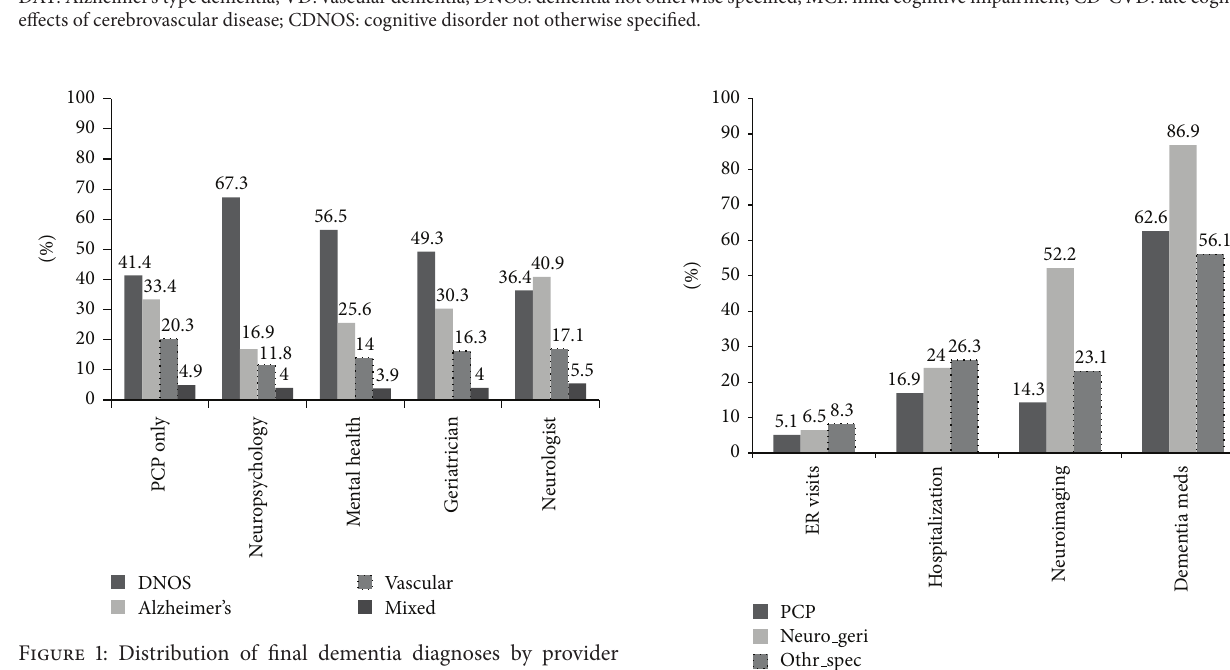
Figure 2: Resource utilization during peridiagnostic period by provider type one year before and after first dementia